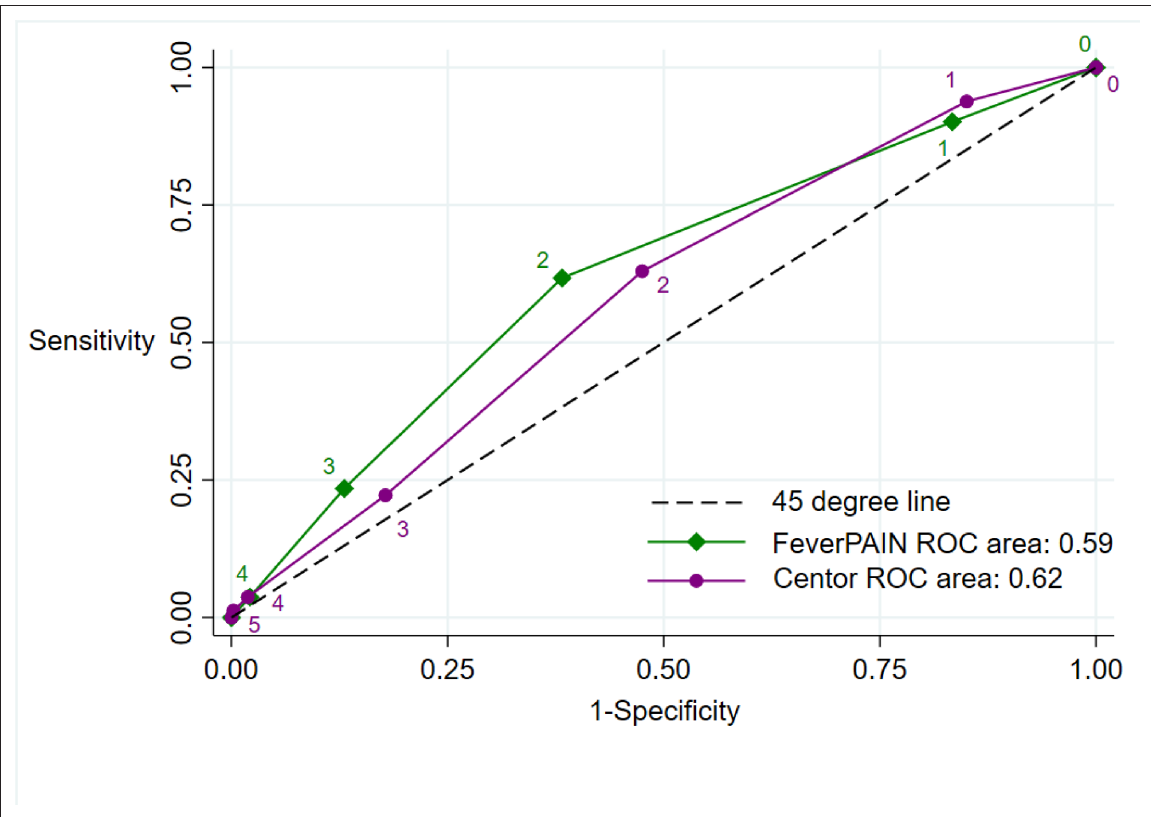
Figure 2 Receiver operating characteristic (ROC) curves for diagnostic accuracy in identifying streptococcal infections for FeverPAIN and Centor clinical prediction rules. All beta- Lancefield group streptococci to include group A, C, and G streptococci strains isolated on agar plates after 48 hours culture. ROC curve analysis showing sensitivity versus 1- specificity each threshold. The different scores are shown next to a point on the graph. Each colour represents the diagnostic accuracy of one clinical prediction rule for streptococcal infection in adults with sore throat.